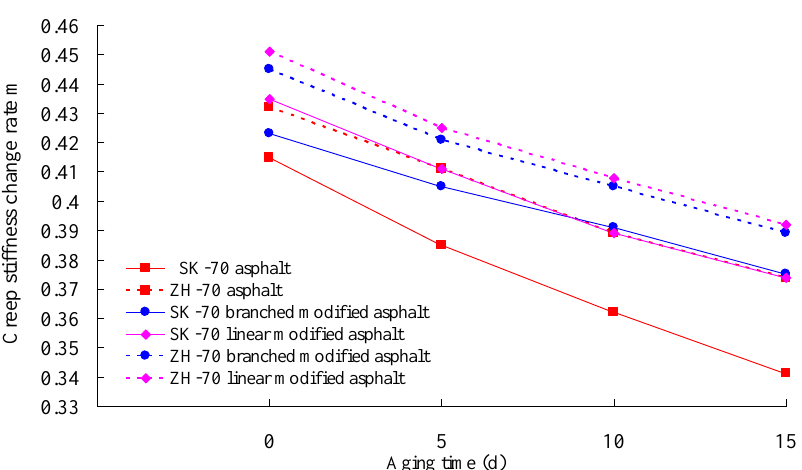
Figure 8. Creep sti ff ness change rate and aging time. Materials 2020 , 13 , x FOR PEER REVIEW